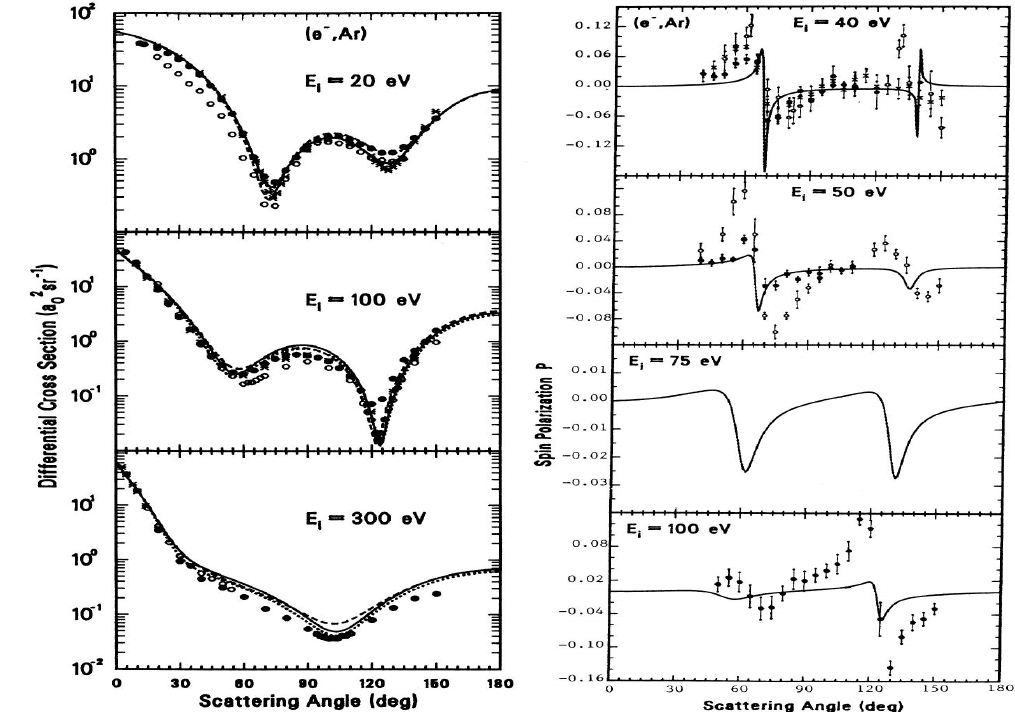
Figure 2. Left : Differential cross sections (DCS) for elastic scattering of electrons from Ar at 20, 100, and 300 eV illustrating features from interference effects and comparing theoretical predictions from optical potential approach with experimental measurements. Theory: solid curve represents use of only real part of the the potential and dot that including both real and absorption potentials [9], dash represents nonrelativistic approach with only real potential [1]). Experimental data corresponds to 7 different measurements: at 20 eV, filled circle [22], open circle [18], at 100 eV, open circle [18], solid circle [20], at 300 eV, filled circle [23], open circle [24], asterisks [19]. Right : Angular dependence of spin polarization P for elastic scattering of electrons from Ar at various electron impact energies. Theoretical prediction from optical potential approach [9] is compared with measured values from